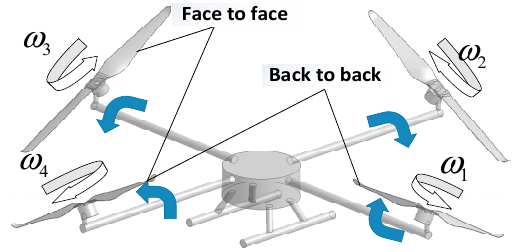
Figure 1. Schematic diagram of the non-planar quadrotor structure.